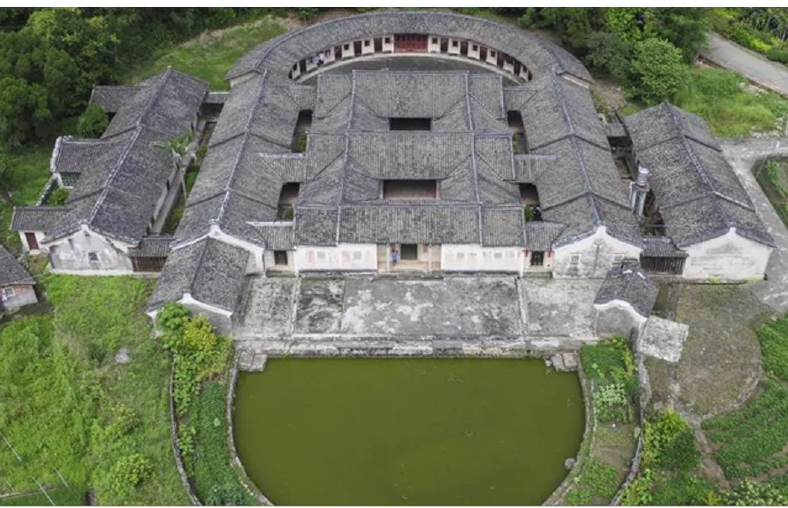
Figure 11. The Dragon House.